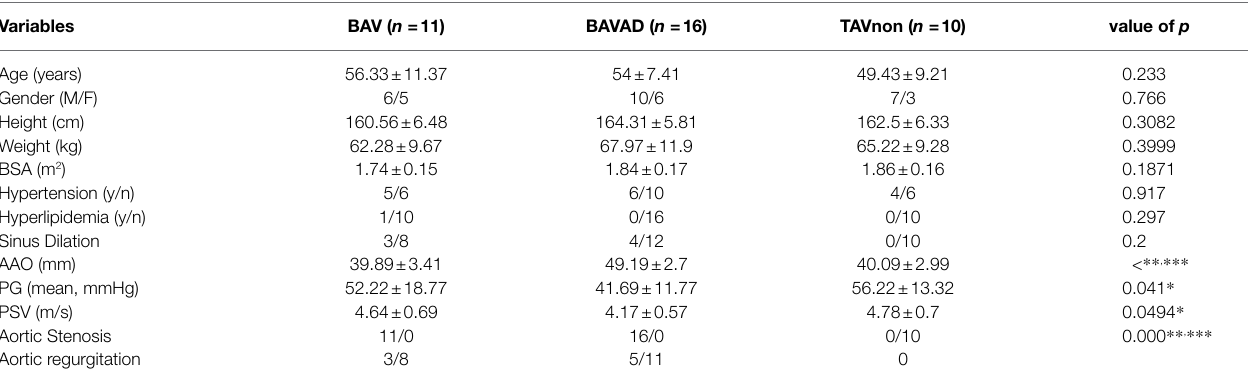
TABLE 2 | Baseline characteristics of validation groups.